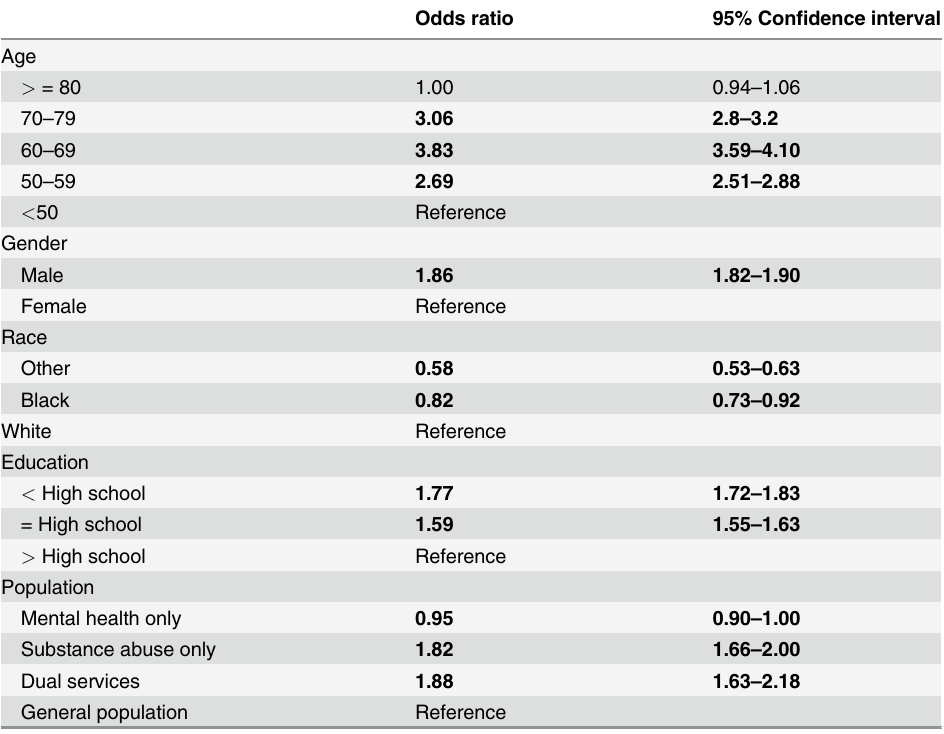
Table 5. Odds ratio estimates for demographics and vulnerably populations for tobacco-related deaths. (N = 148,761) *